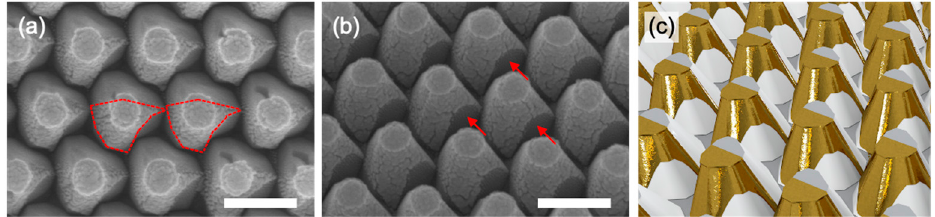
Figure 2. ( a , b ) SEM images after oblique (45°) deposition of Au onto a PSS (( a ): top view, ( b ): 45° tilted view). Scale bars in the images are 300 nm. Red lines in ( a ) and arrows in ( b ) indicate Au nanostructure and the shadowing effect due to adjacent triangular pyramids, respectively. ( c ) Schematic illustration of obliquely deposited (45°) Au on PSS.